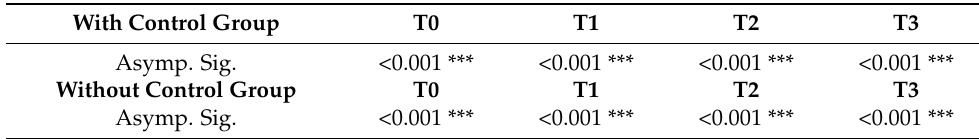
Table 2. Kruskal–Wallis H test results for general differences between the four study groups regarding fluoride release.